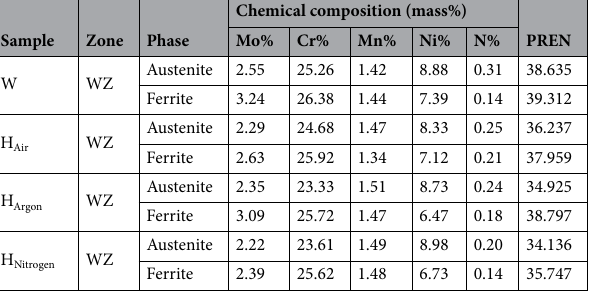
Table 5. Chemical composition of austenite and ferrite phase for the test samples and PREN of WZ after four times EDS measurement.